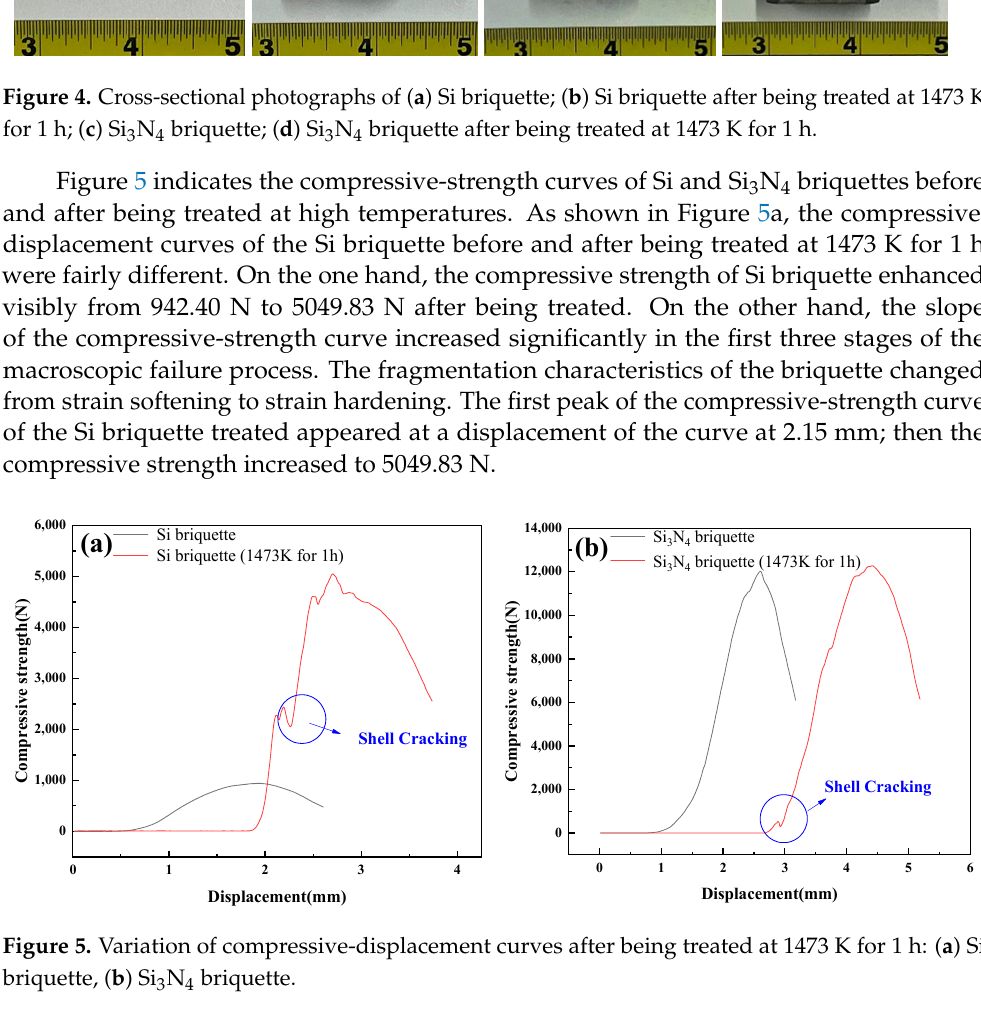
Figure 5. Variation of compressive-displacement curves after being treated at 1473 K for 1 h: ( a ) Si briquette, ( b ) Si 3 N 4 briquette.